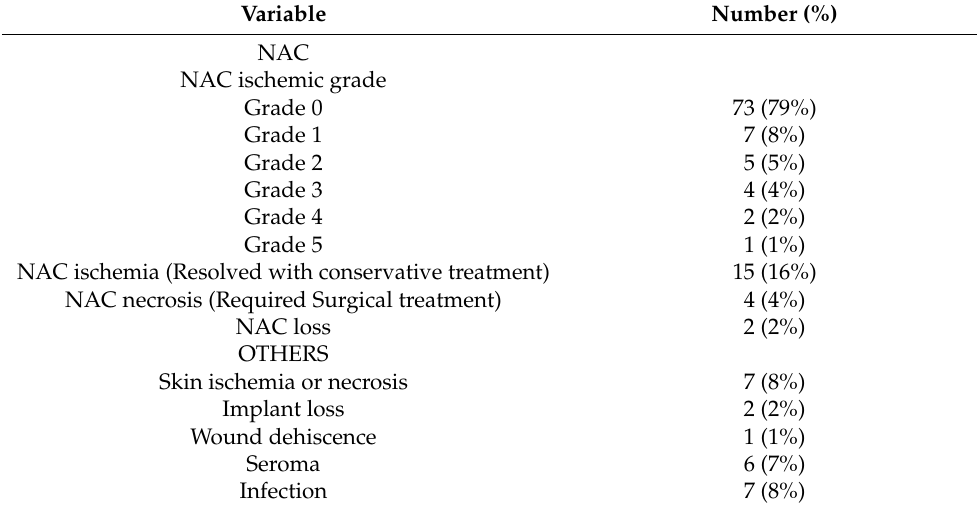
Table 3. Incidence of postoperative